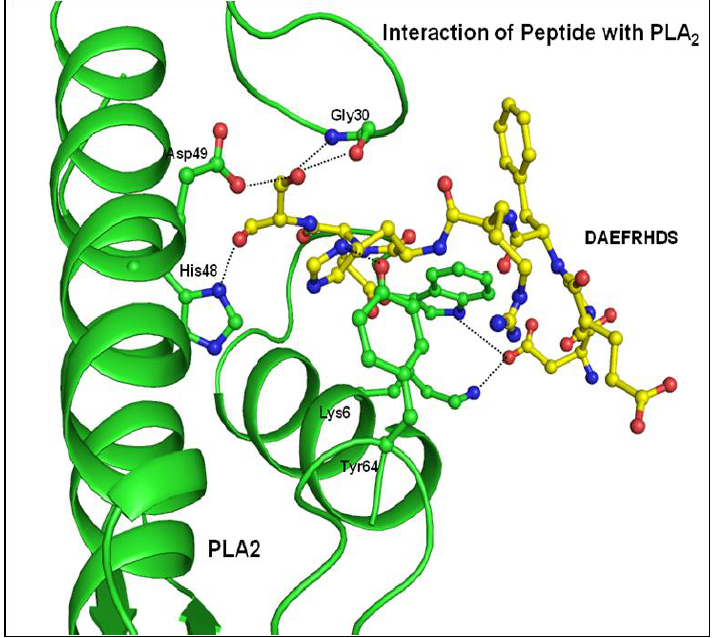
Figure 5. Interactions between PLA and the peptide Asp-Ala-Glu-Phe-Arg-His-Asp-Ser. 2 The peptide residues are colored yellow. The critical interactions between peptide and protein are shown by the dotted line.